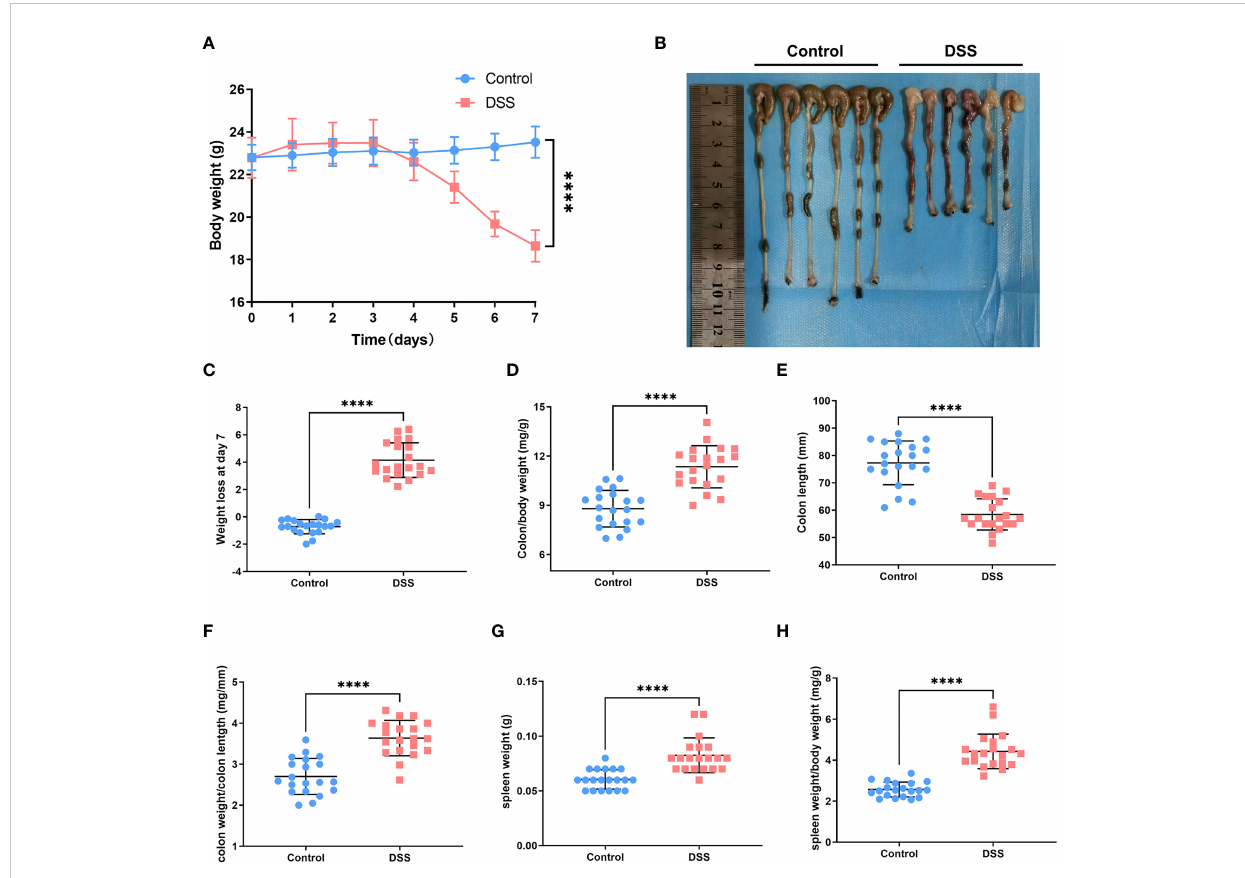
FIGURE 6 Experimental veri fi cation in the UC mouse model. (A) Changes in body weight of mice in the normal and dextran sulfate sodium (DSS) groups. (B) Colon length in the control group versus that in the DSS group. (C) DSS-treated mice had signi fi cant loss of body weight compared with control mice. (D) After acute DSS administration, the colon/body weight ratio was signi fi cantly higher in DSS-treated mice than in control mice. (E) Colon length decreased in DSS-treated mice compared with that in control mice. (F) Colon weight/length ratio increased after acute administration of DSS. (G) Spleen weight of mice in the DSS group was substantially higher than that of mice in the control group. (H) Spleen weight/body weight ratio increased after acute administration of DSS (**** p <